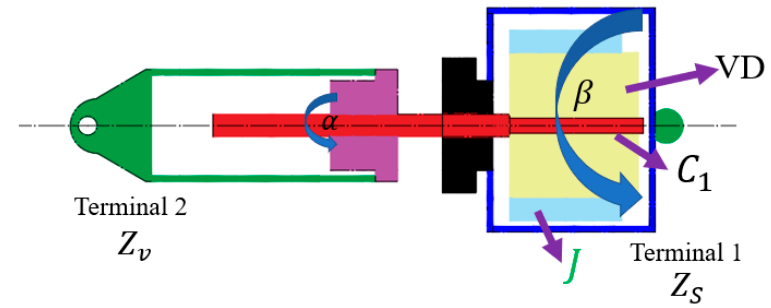
Figure 2. The model of the VEI